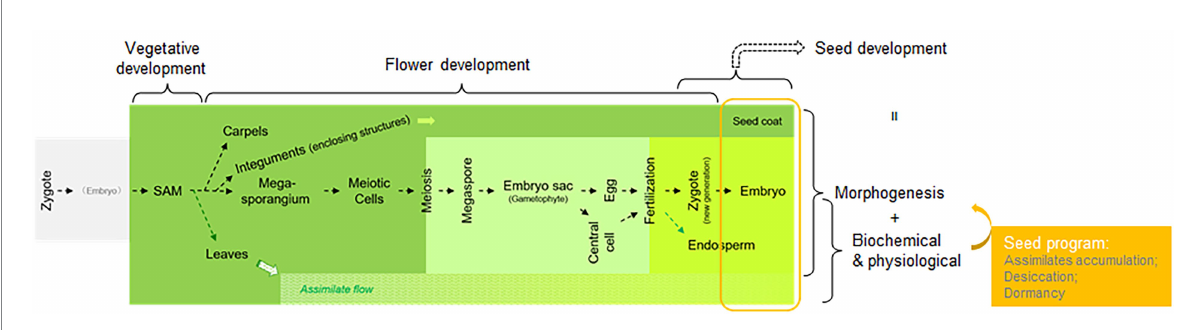
FIGURE 1 A diagram illustrating the meaning of the “seed program” in the context of the angiosperm life cycle and mainstream study of seed development. Different stages of the angiosperm life cycle are assigned as different research topics, such as vegetative, flower, and seed development, with some overlaps. The sporophyte of the plant, derived from a zygote, is labeled in dark green; the gametophyte is pale green; and the sporophyte of the new generation enclosed within the maternal sporophyte is bright green. The assimilate flow is labeled.